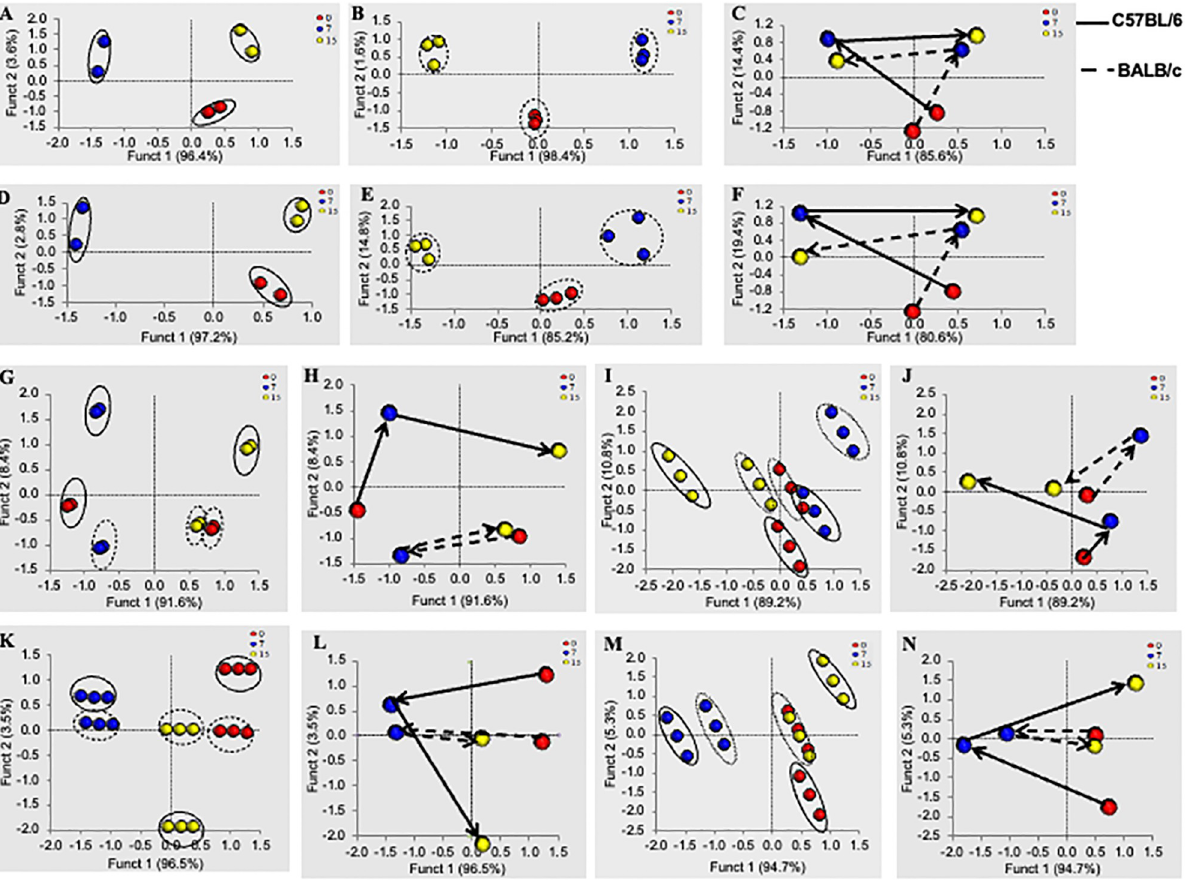
Fig 2. Linear discriminant analysis of multi-omics data and the trajectory followed by different treatment conditions on the 2D plane. We grouped the mice strain using Linear Discriminant Analysis (LDA) based on transcriptomics, metabolomics, and meta-metabolomics data according to the different treatment conditions. We showed LDA of the total gene expressed in the colon (A, B) and significantly altered genes in the colon (D, E) following DSS treatment on days 0, 7, and 15 in both C57BL/6 (A, D) and BALB/c (B, E) mice. We plotted the trajectory of LDA data of total gene expression (C) and significantly altered gene expression (F) in the colon to determine the differential responses based on different treatment conditions and different mice strains. Similarly, we showed LDA of total metabolites (G) and significantly altered metabolites (K) present in serum and total meta- metabolites (I) and significantly altered metabolites (M) present in cecal content followed by DSS treatment in both C57BL/6 and BALB/c mice. To know the differential responses based on the treatment conditions and different mice strains, we also plotted the trajectory of LDA data of total metabolites (H) and significantly altered metabolites (L) present in serum and total meta-metabolites (J) and significantly altered metabolites (N) present in cecal content. Distance between the clusters and the trajectory on the 2D plan for all the analyses is mentioned in detail in S2 Table. This analysis gives us a better understanding of differential responses of C57BL/6 and BALB/c in the presence of an equivalent dose of DSS treatment.